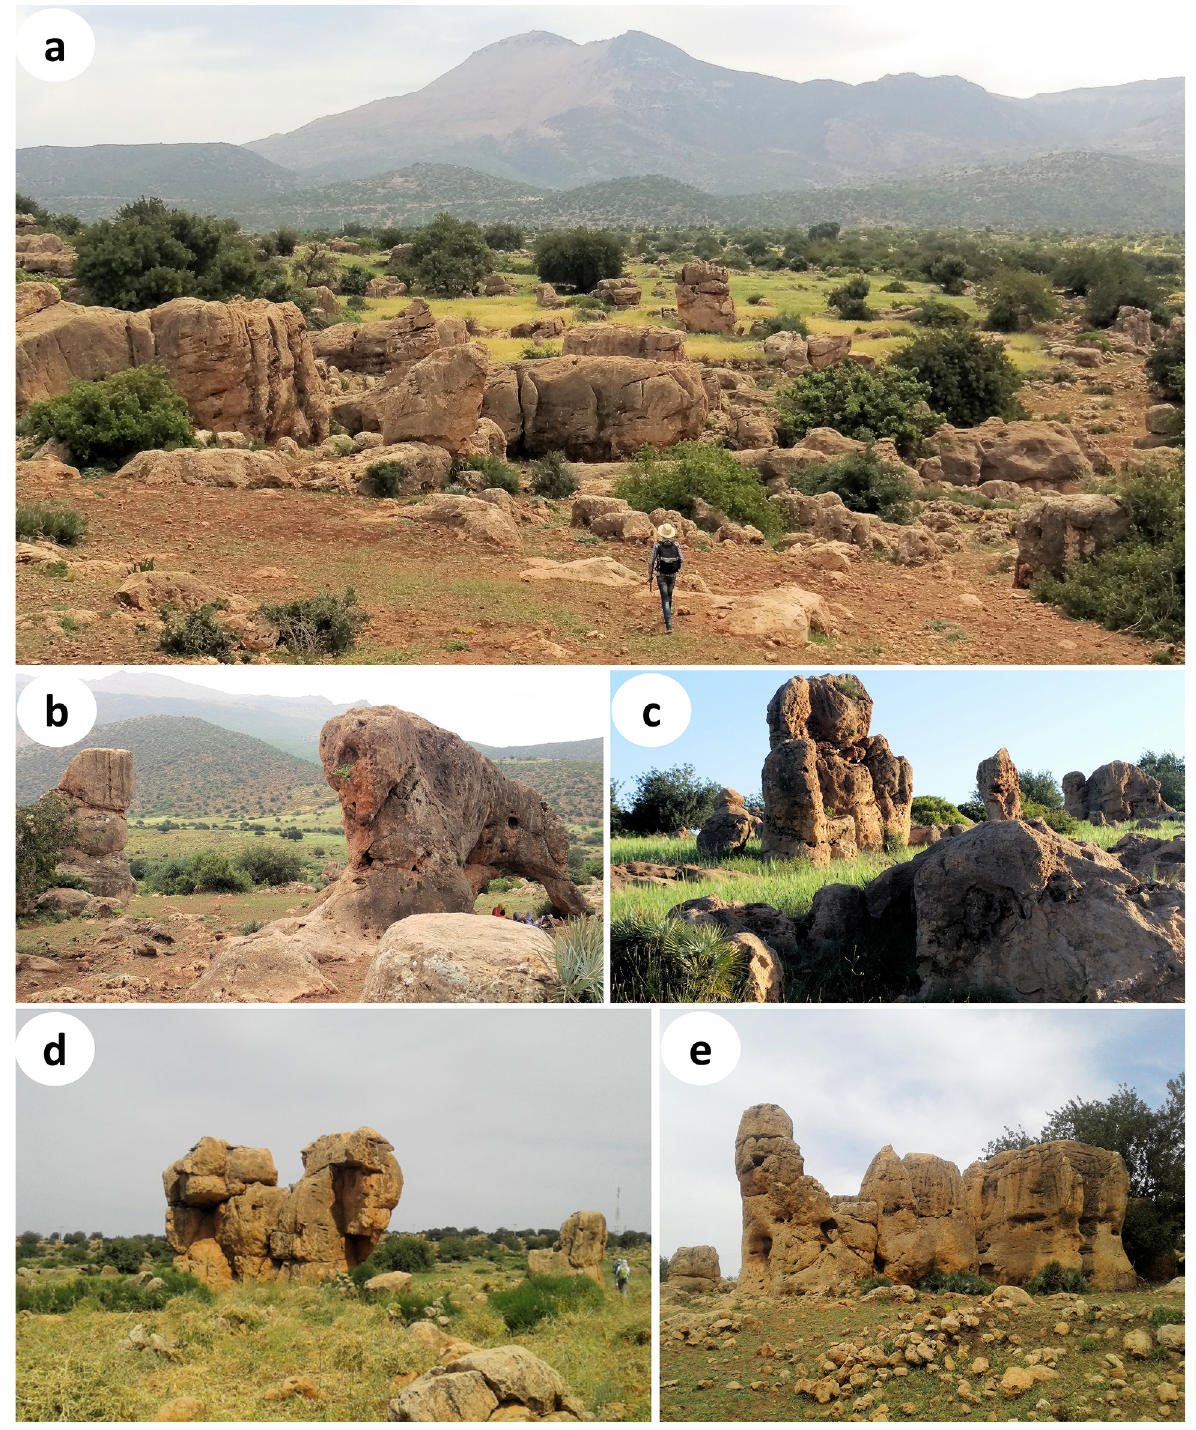
Fig. 8. The ruiniform landscapes of the Orbia site of varying shapes and